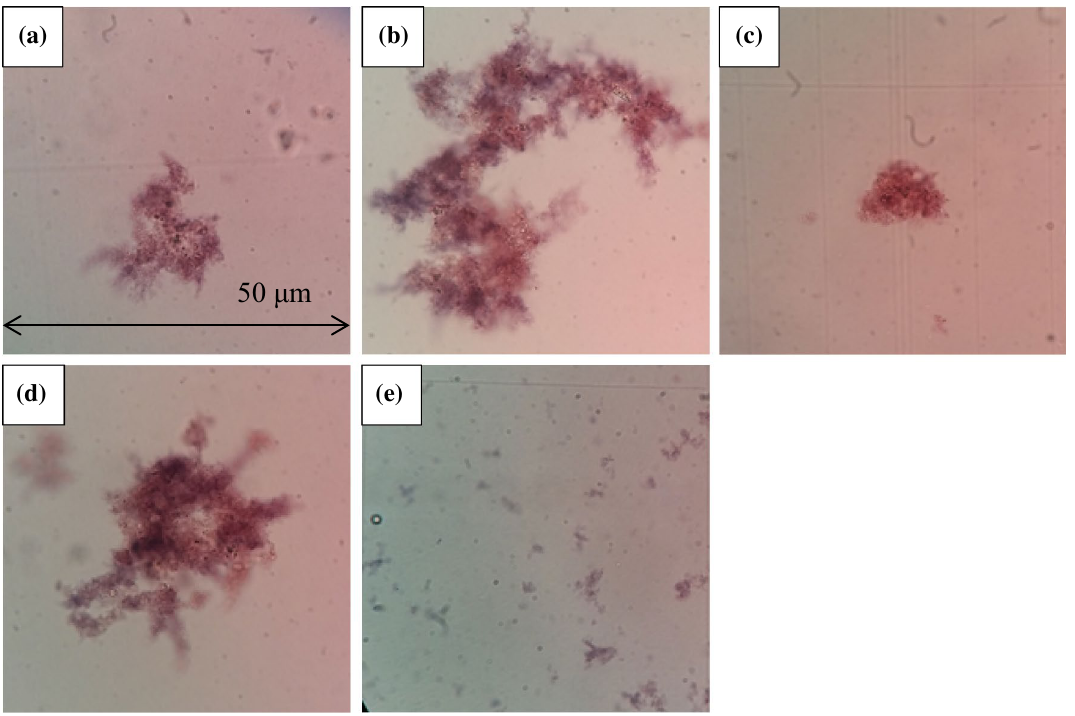
Fig. 4 Microscope observation of floc formation at 400× for sample leucaena seed kernel extract dosage 10 mL L −1 sampling at 15 min ( a ),